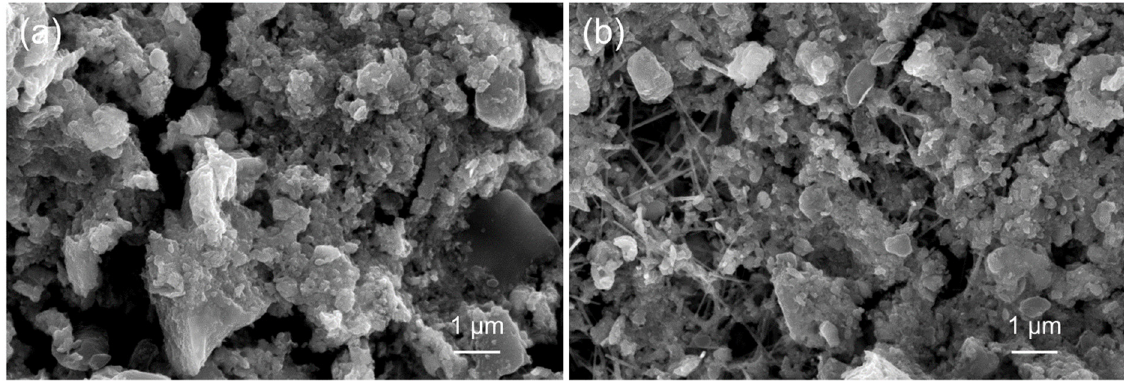
Figure 1. SEM images of ( a ) pristine WS 2 and ( b ) 10 wt% SnO 2 –WS 2 composite.